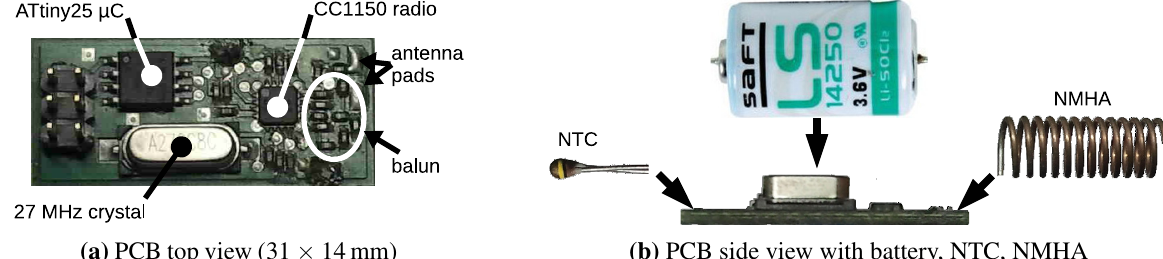
Figure 3. Sensor node prototype: PCB for laboratory tests ( a ); and prepared for field tests with manually soldered NTC , normal mode helix antenna (NMHA) and battery ( b ); the RF performance is limited by the balun layout (a) and the proximity to the antenna of ferromagnetic crystal case and battery seal